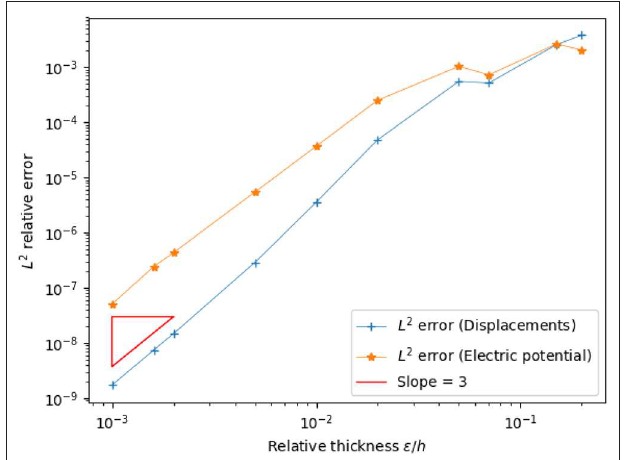
Frontiers in Materials |